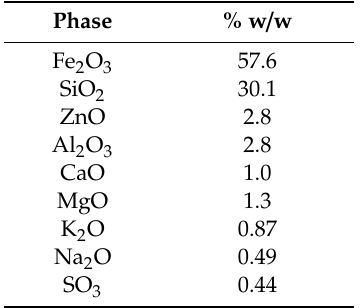
Table 2. Chemical composition (% w / w) of the copper